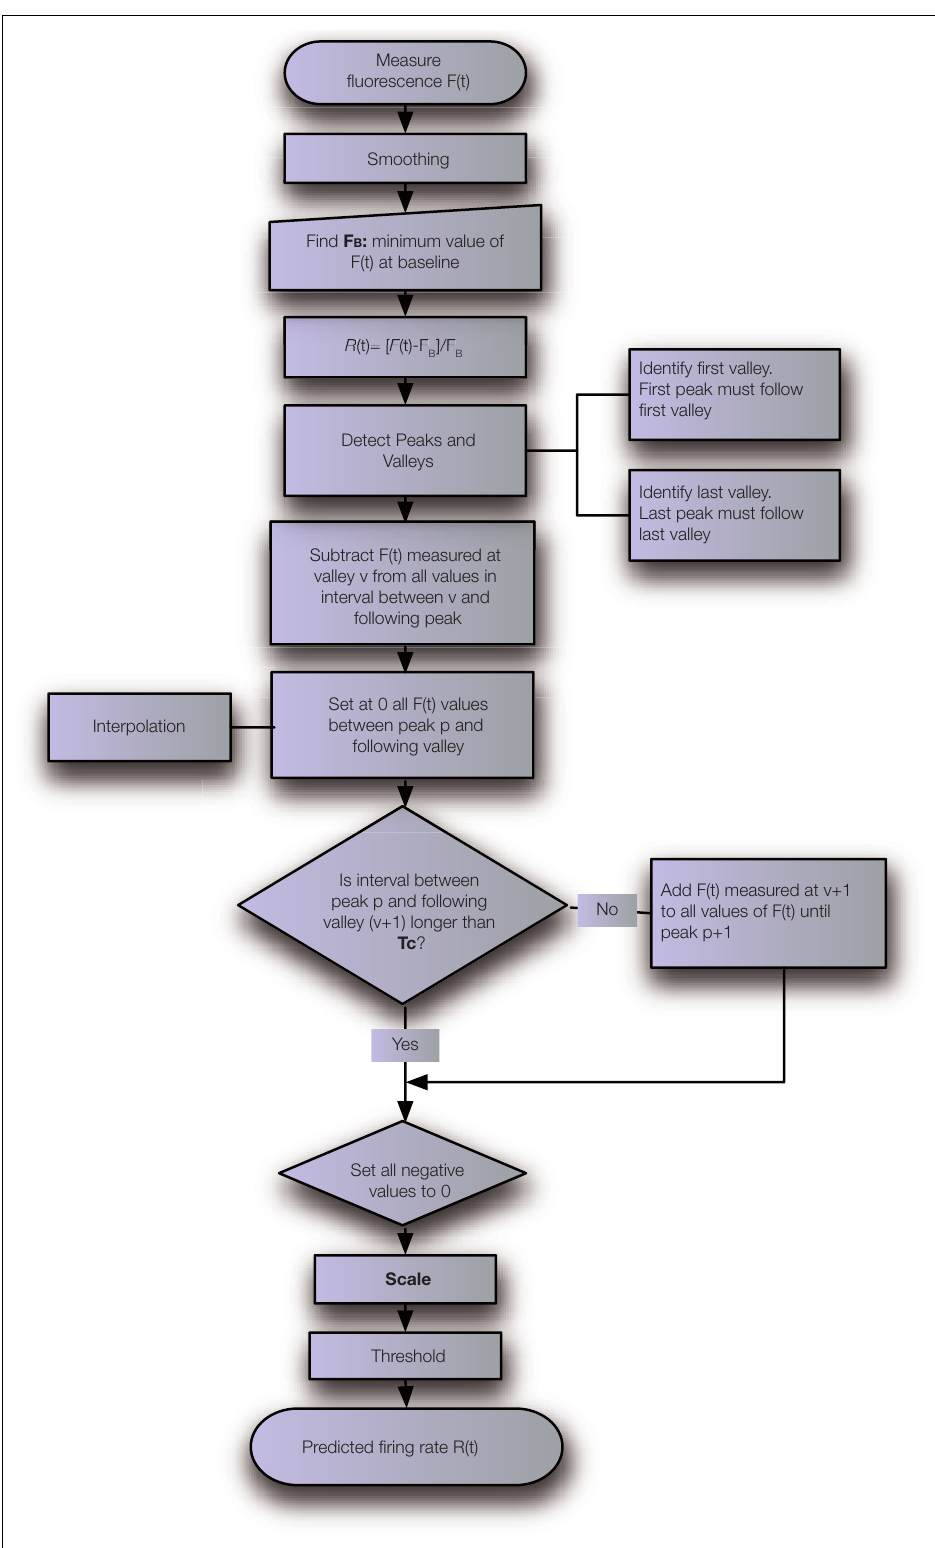
Figure 3 | Simple algorithm used to transform the measure of a calcium indicator fl uorescence F (t) into a prediction of the fi ring rate R (t) . The algorithm relies on the determination of two parameters: a time parameter T and a scaling factor S specifi c to the indicator and to the cell type under